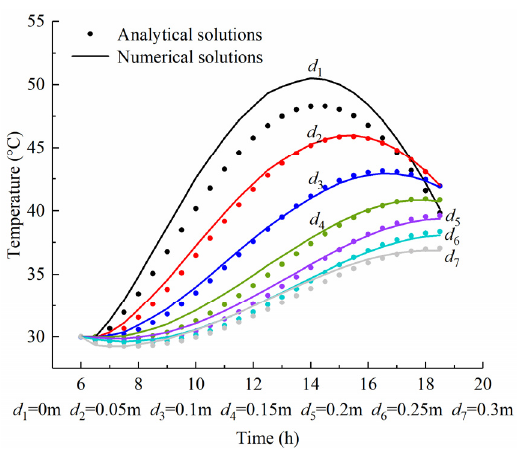
Figure 14. Comparison between numerical solutions and analytical solutions ( n = 9).